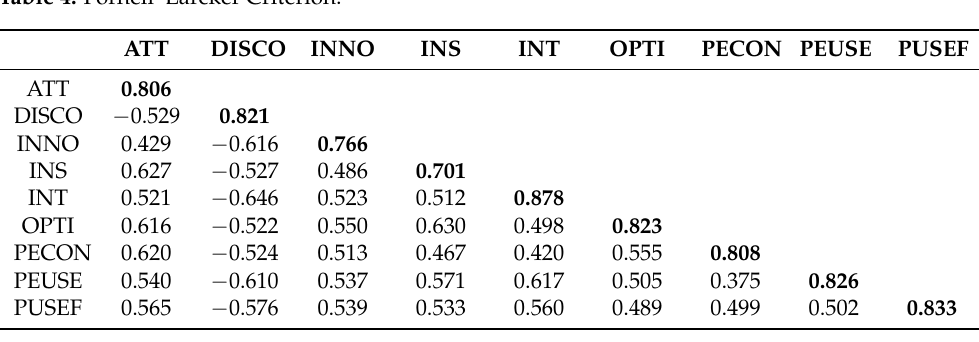
Table 4. Fornell–Larcker